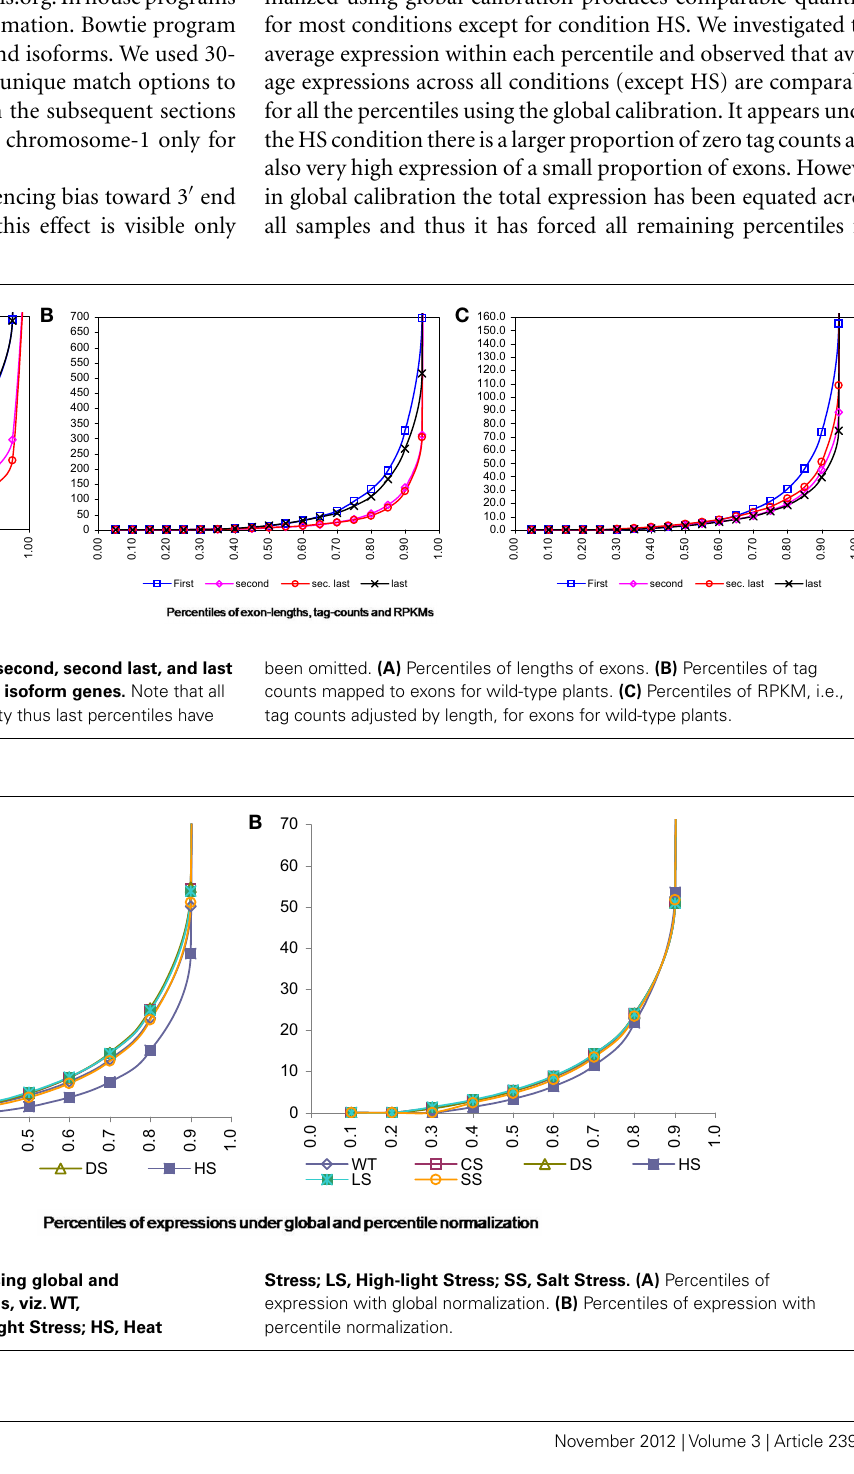
FIGURE 3 | Percentiles of expression data using global and percentile normalization for all six conditions, viz.WT, Wild-type-control; CS, Cold Stress; DS, Draught Stress; HS, Heat